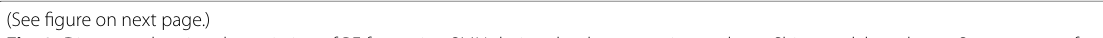
(See figure on next page.) Fig. 2 Diagrams showing the variation of PE for station SMN during the three eruption cycles at Shinmoedake volcano. Spectrograms for the same time periods are shown at the bottom of each PE plot and spectral amplitudes follow the colored scales at the right. The double arrows on top of each diagram delineate the three different periods discussed in the main text. The green dashed line in the top panel indicates the time of the